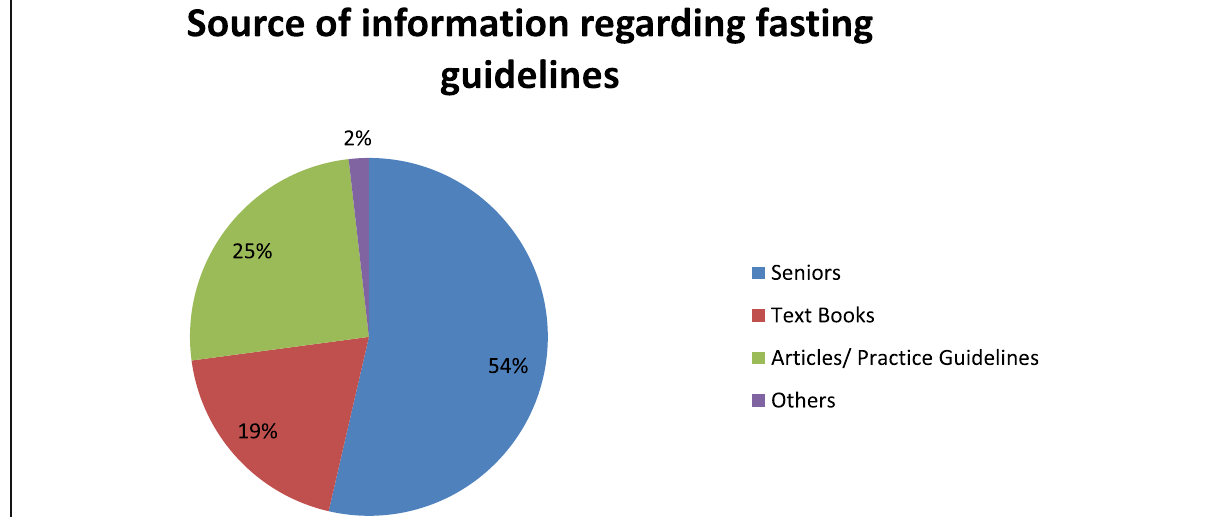
Fig. 2 Summary of source of information regarding fasting guidelines of postgraduate trainee